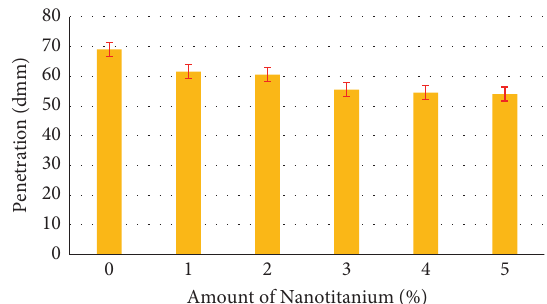
Figure 9: Penetration values of nano TiO